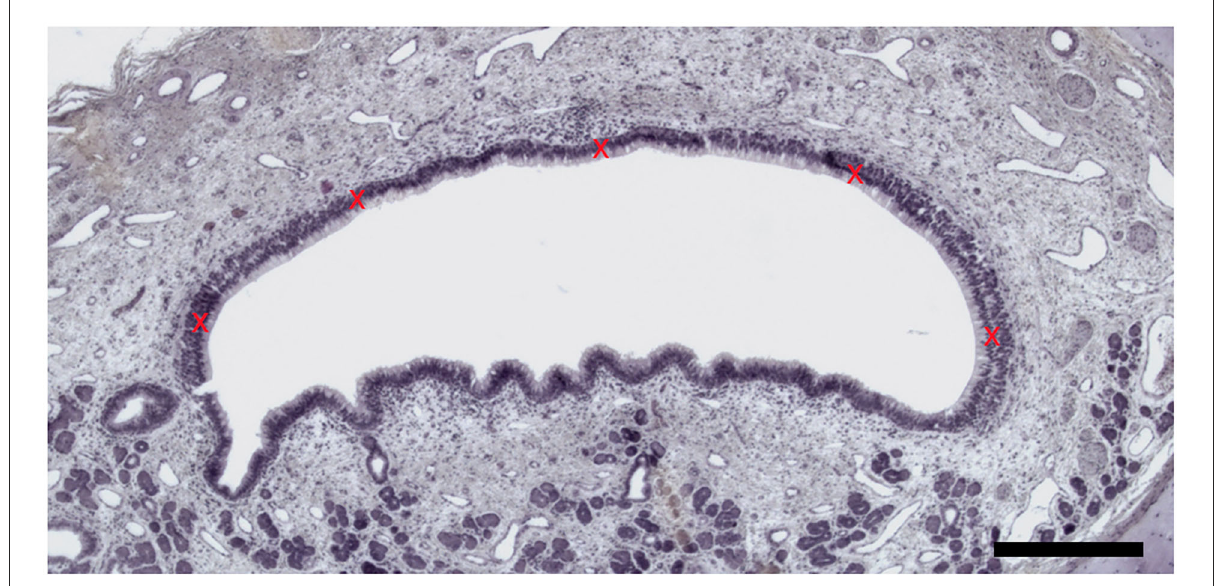
FIGURE1 Vomeronasal sensory epithelium thickness measurement. Five measures (red crosses) were taken by VNSE. (Hematoxylin and eosin (H&E) staining, Objective x10, Scale bar 100 µ m).